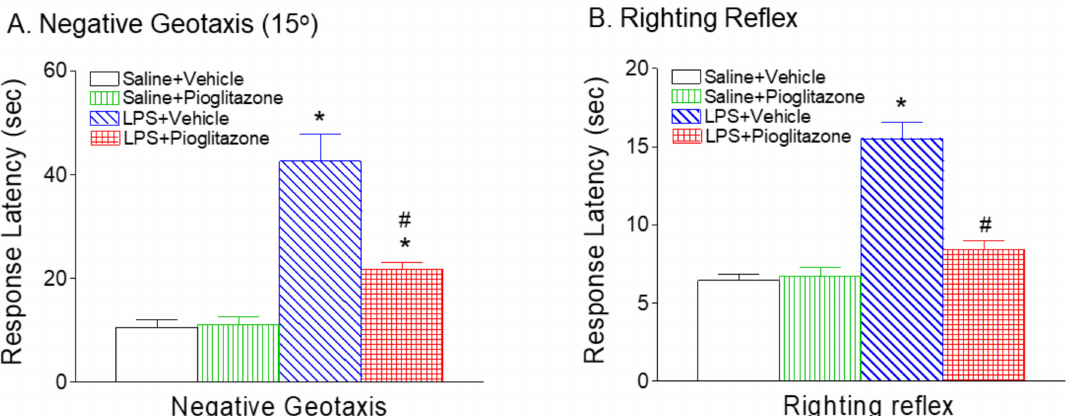
Figure 3. Pioglitazone attenuated neonatal LPS-induced elongation of mean latency times in negative geotaxis ( A ) and righting reflex ( B ) in the rat. The results are expressed as the mean ± SEM of eight animals in each group, and analyzed by two-way ANOVA, followed by the Student–Newman–Keuls test. * p < 0.05 represents a significant difference for the LPS + Vehicle group or LPS + Pioglitazone group as compared with the Saline + Vehicle group. # p < 0.05 represents a significant difference for the LPS + Pioglitazone group as compared with the LPS + Vehicle